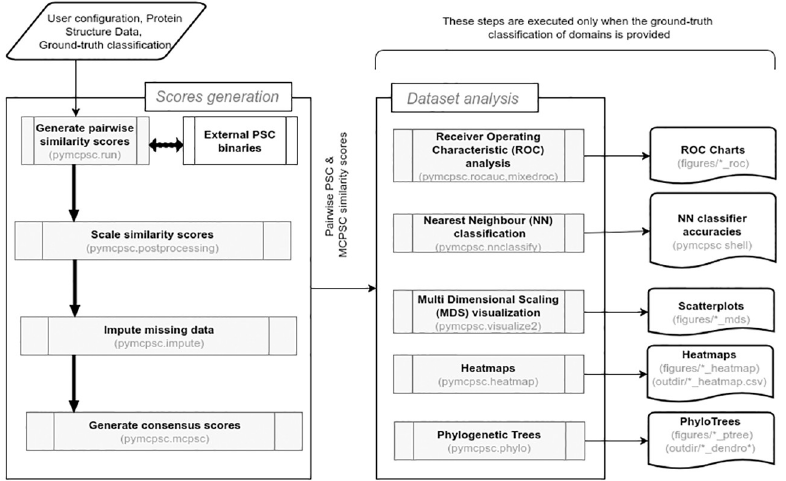
Fig 1. Schematic overview of the architecture of pyMCPSC . pyMCPSC is organized into several modules, each one implementing a specific functionality. The main entry point of the utility drives the sequence of activities shown. Similarity scores are generated for all protein pairs using the executable binaries of the included PSC methods. Subsequently the scores are scaled, missing data (similarity scores) are imputed and consensus MCPSC scores are calculated for all domain pairs. If the user has supplied ground-truth domain classification information, then comparative analysis results are also generated based on the similarity scores. The modules where the respective functionalities are implemented are specified in